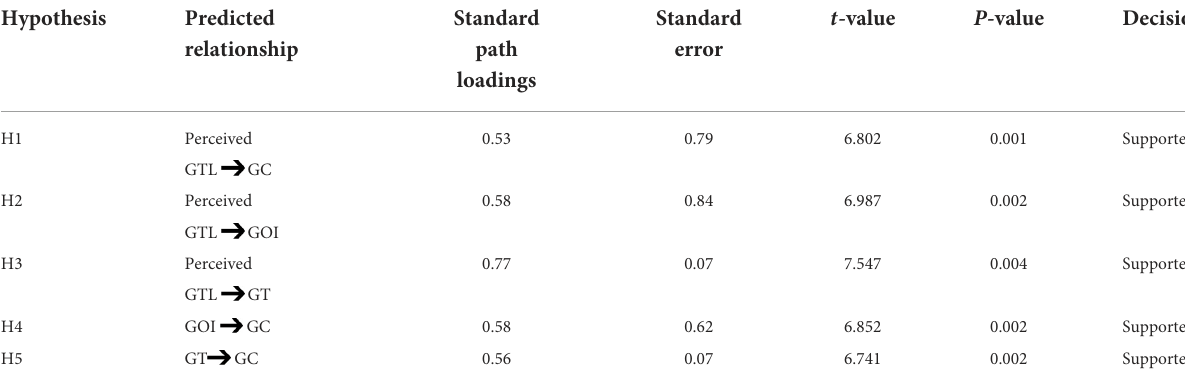
TABLE 5 Regression results of the structural model and hypotheses test outcomes. Hypothesis